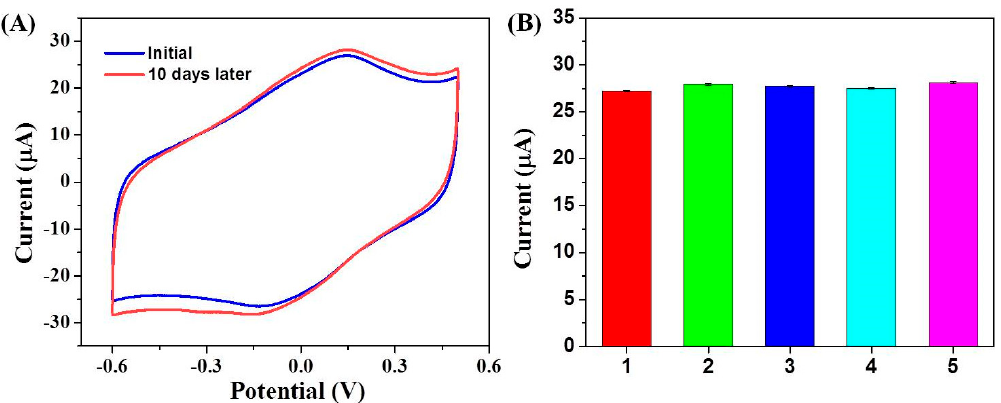
Figure 6. ( A ) CV curves of the GCE/ERGO-Nafion/AuNPs/Cyt c/Nafion electrode as-prepared and stored in PBS at 4 ◦ C 10 days later. ( B ) Amperometric response of five GCE/ERGO-Nafion/AuNPs/Cyt c/Nafion electrodes to 200 µ M H 2 O 2 in a 0.2 M PBS (pH = 7.4) at a rate of 50 mV/s. The relative standard deviation (RSD) of each point is less than 0.35%. Table 1. Amperometric response against the addition of different amounts of H 2 O 2 into a 1 mM H 2 O 2 solution.